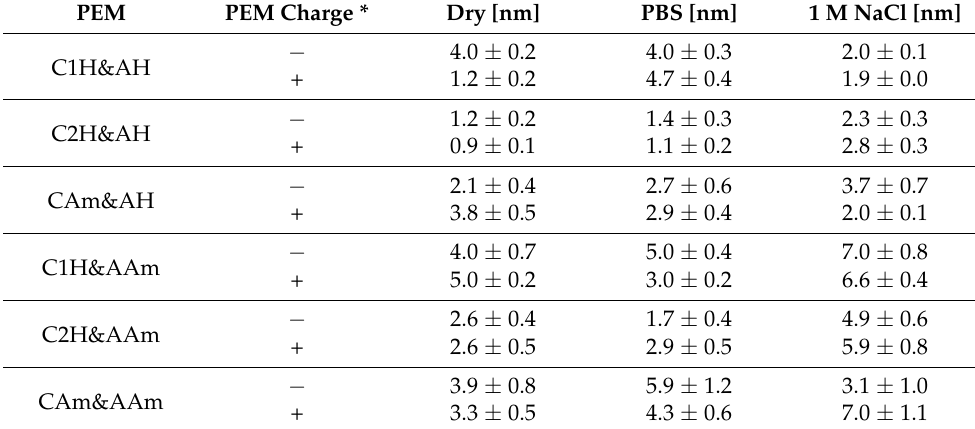
Table 4. RMS roughness of PEMs supported on silicon. PEMs with negatively and positively charged topmost layer consisted of 14 and 15 layers, respectively. Dry and swollen for 30 min in PBS or 1 M NaCl solution samples were used. PEM Charge